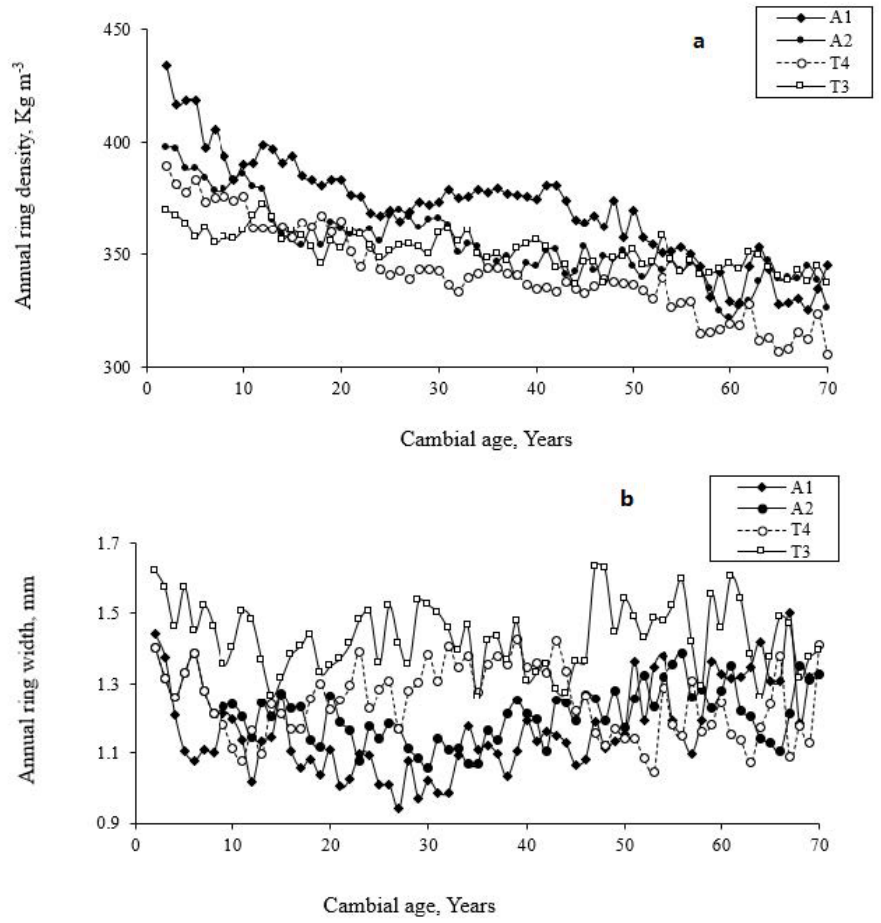
Figure 4. Variation of ( a ) annual ring density (RD, kg m − 3 ) and ( b ) annual ring width (RW, mm) in Thuja occidentalis at selected sites (A1, A2, T3, and T4) in the Abitibi-Témiscamingue, Quebec, Can- ada.